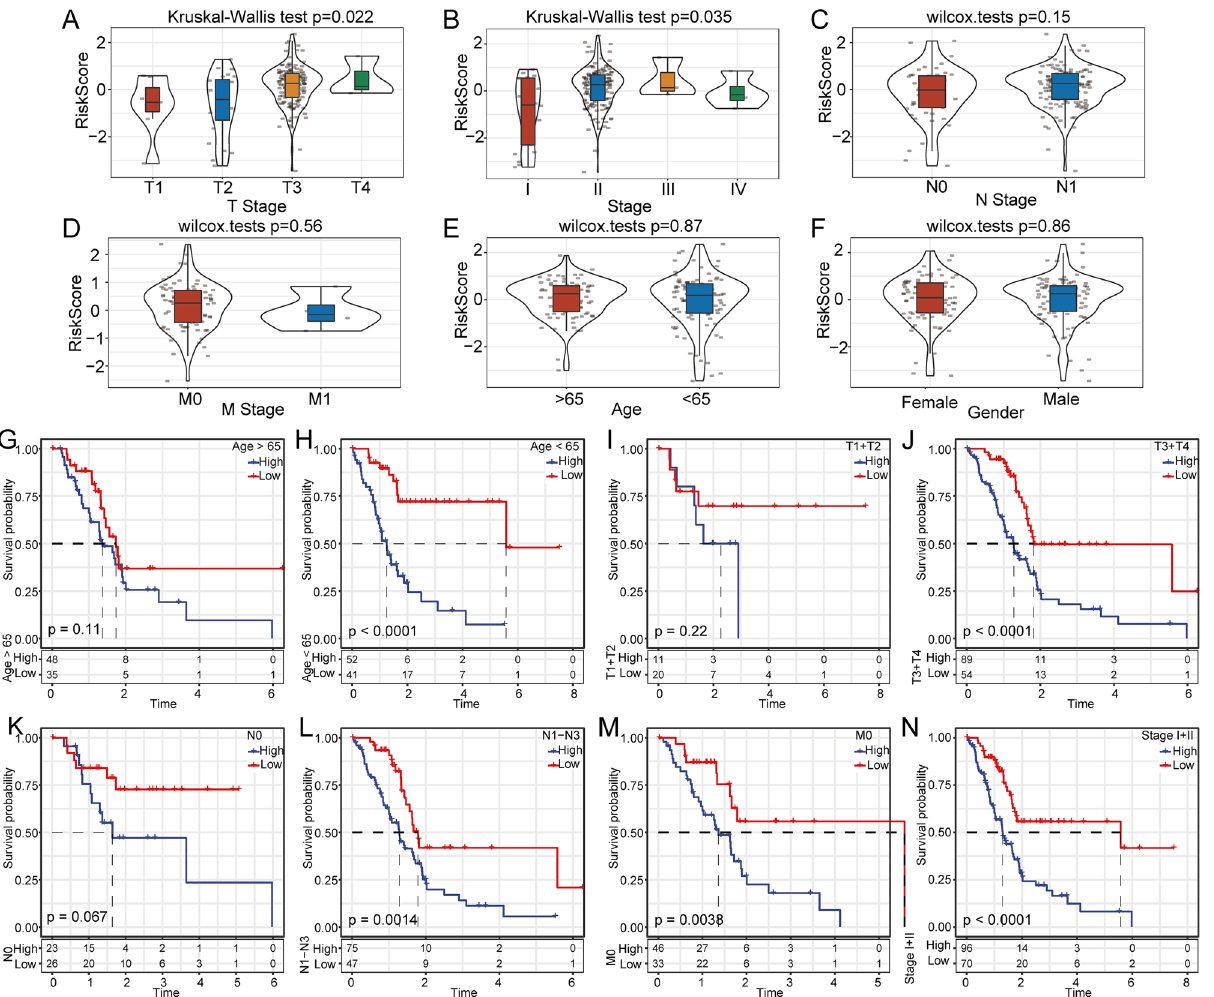
Figure 7. Clinical features of the high- and low-risk subgroups. ( A – F ) Risk score comparison of patients with different clinical features in the TCGA-PACA dataset. ( G – N ) Comparison of the overall survival of risk groups in subgroups with different clinical